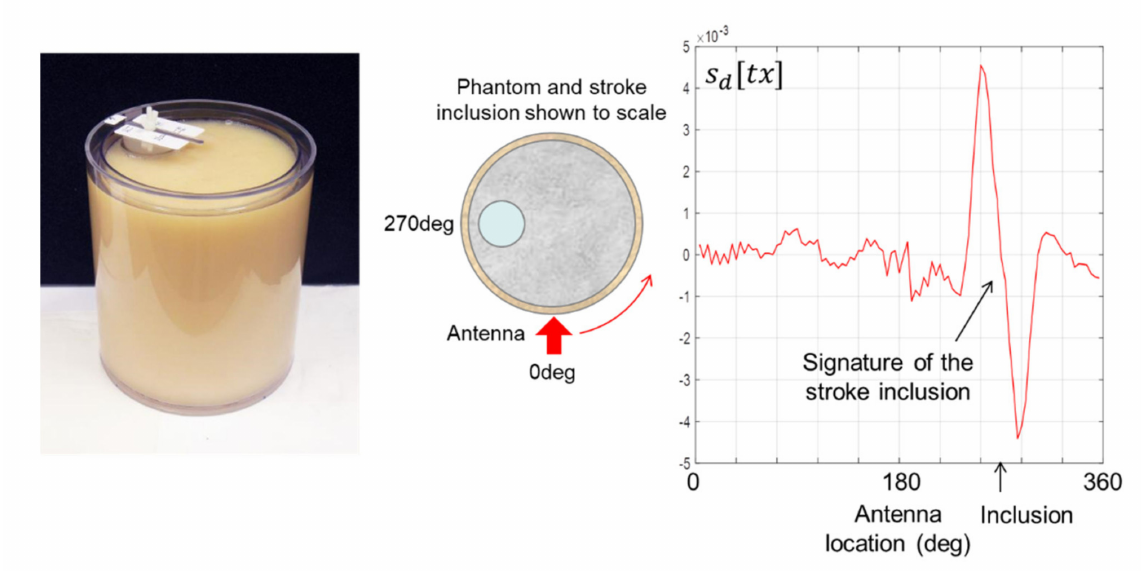
Figure 11. Signature of a 44 mm inclusion in the 175 mm